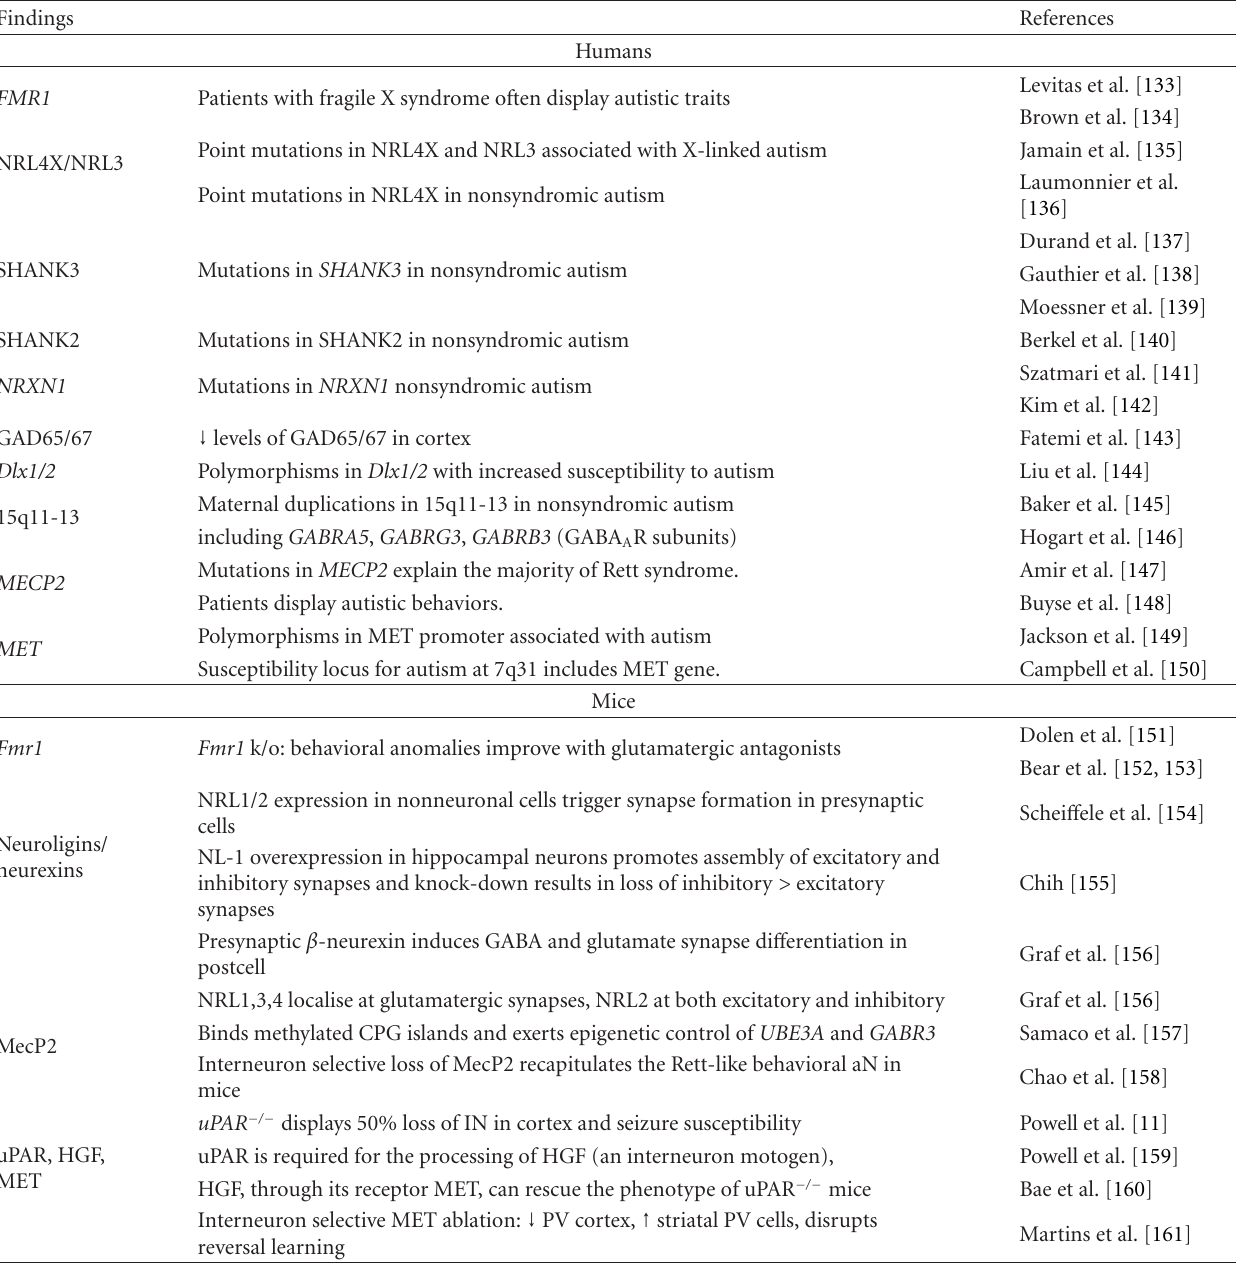
Table 2: Findings in autistic children and correlations in mice